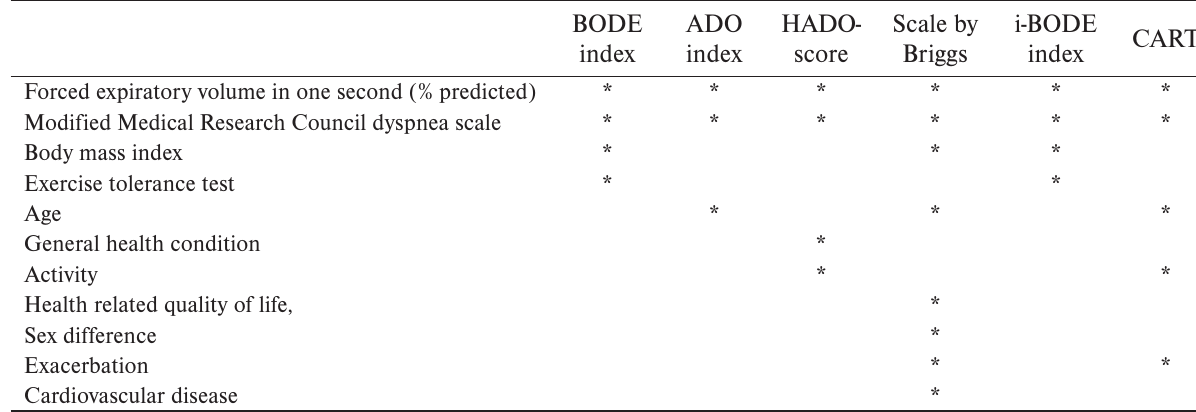
Table 1. Components of major validated COPD prognostic